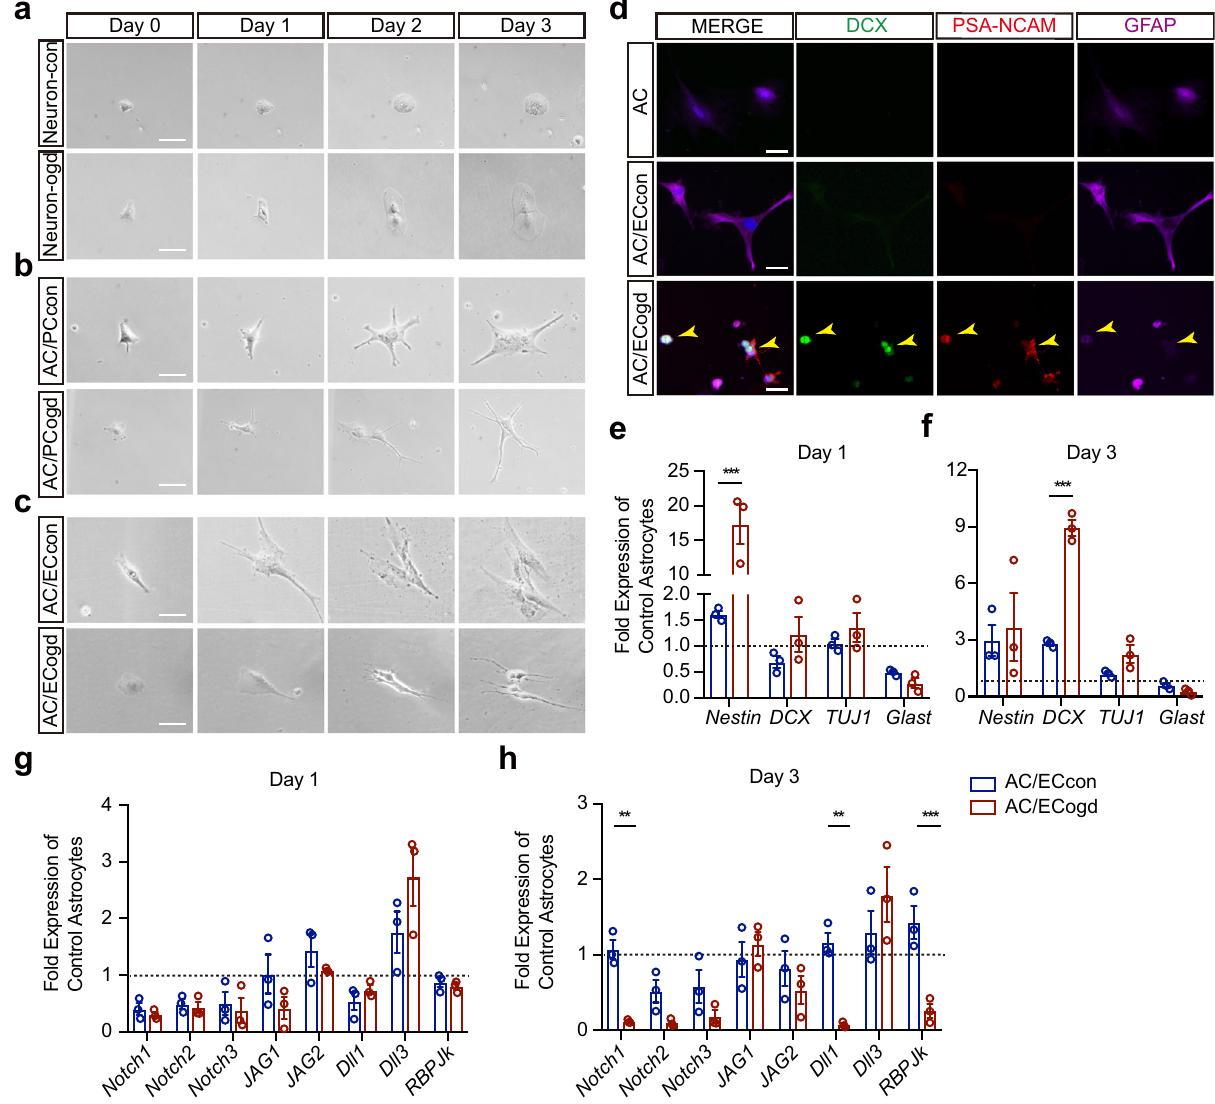
Fig. 1 | Oxygen-glucose deprivation-stimulated brain endothelial cells convert astrocytes into neural progenitor cells. a Morphologic changes of same astro- cytes (AC) at day 0, day 1, day 2 and day 3 post cultured in conditioned neuron media collected from normal neurons (Neuron-con) or OGD-stimulated neurons (Neuron-ogd). b Morphologic changes of same AC at day 0, day 1, day 2 and day 3 post co-cultured with normal pericytes (PCcon) or OGD-stimulated pericytes (PCogd). c MorphologicchangesofsameACatday0,day1,day2andday3postco- cultured with normal brain endothelial cells (ECcon) or OGD-stimulated brain endothelial cells (ECogd). d Representative immunostaining of DCX, PSA-NCAM andGFAPinACoratday3postACco-culturedwithECconorECogd. e mRNAlevels of Nestin , DCX , TUJ1 and Glast at day 1 post AC co-cultured with ECcon or ECogd;